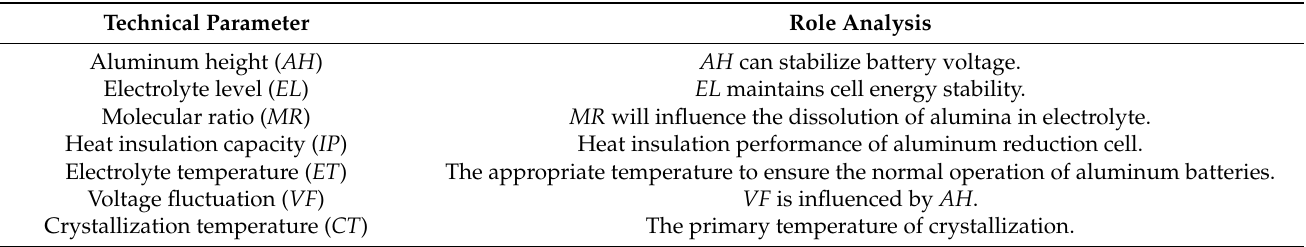
Table 1. Selected technical parameters.